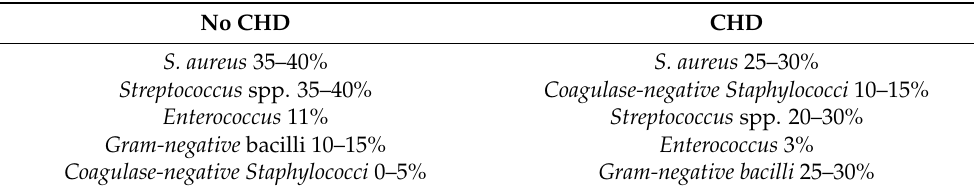
Table 2. Etiology of pediatric infective endocarditis according to the history of congenital heart disease (CHD)